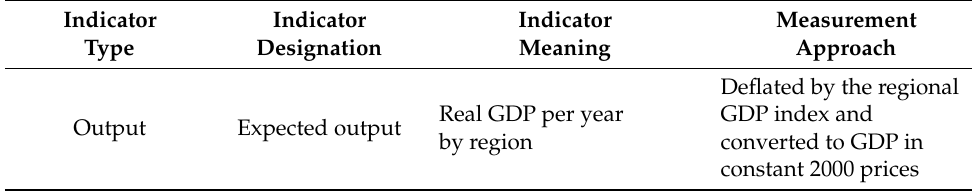
Table 1. Specification of GTFP input–output